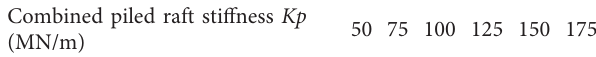
Table 10: Combined piled raft stiffness values